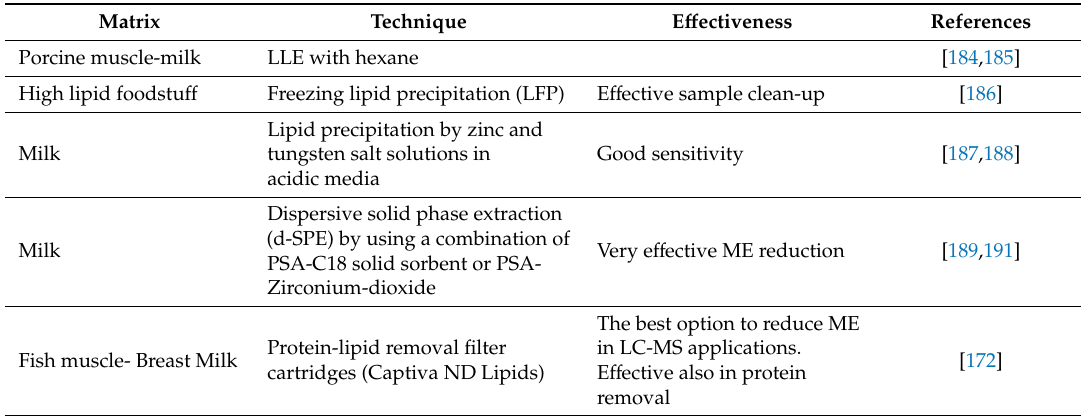
Table 6. List of the lipid removal